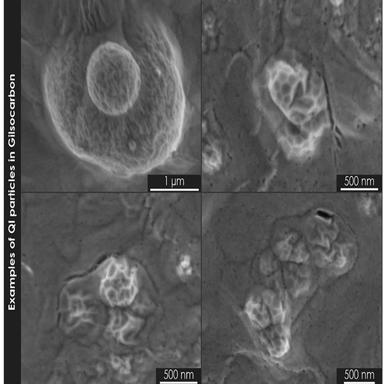
SEM micrographs of QI particles found on the binder phase of a Gilsocarbon sample.